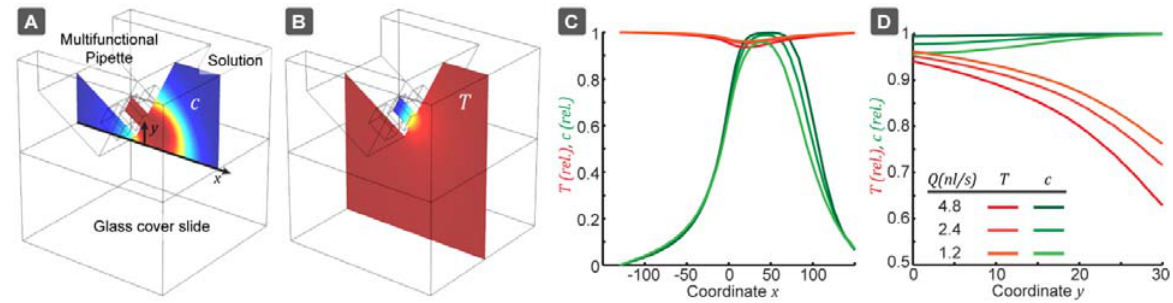
Figure 2. Finite element model of the pipette thermometer. ( A ) Hydrodynamic confinement of the fluorescent dye. ( B ) Thermal equilibration of the out-flowing solution. ( C ) Concentration and thermal equilibration profile along the bottom surface of the chamber (e.g. culture dish) and vertically in front of the pipette tip ( D ), for different flow rates Q. The graphs are normalized such that 0 corresponds to the surrounding liquid composition (C) and completely non-equilibrated temperature (T), while 1 corresponds to outflow composition and full thermal